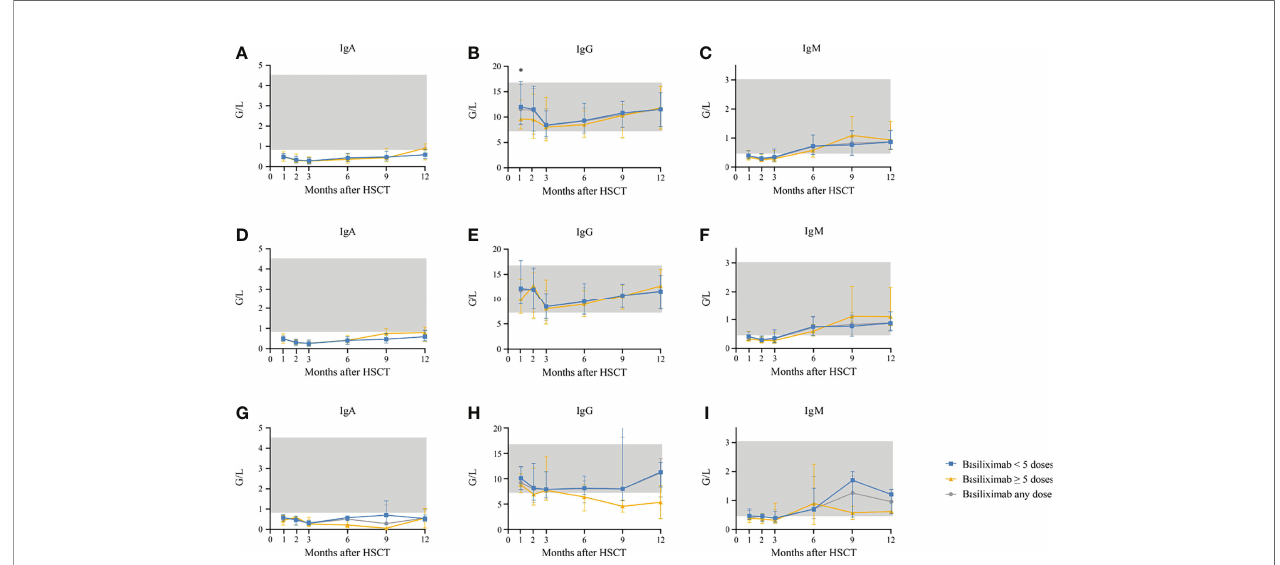
FIGURE 5 | (A – C) Kinetics of IgA, IgG, and IgM in the total population who showed an ORR after basiliximab treatment; (D – F) Kinetics of IgA, IgG, and IgM in grade II SR-aGVHD patients who showed an ORR after basiliximab treatment; (G – I) Kinetics of IgA, IgG, and IgM in grade III – IV SR-aGVHD patients who showed an ORR after basiliximab treatment. IgA, IgG, and IgM are compared between basiliximab <5 doses and basiliximab ≥ 5 doses. Data are shown as median absolute counts with error bars indicating the 25th – 75th percentiles. The gray areas represent the normal range. * P < 0.05, basiliximab <5 doses vs. basiliximab ≥ 5 doses. ORR, overall response rate; SR-aGVHD, steroid-refractory acute graft-versus-host